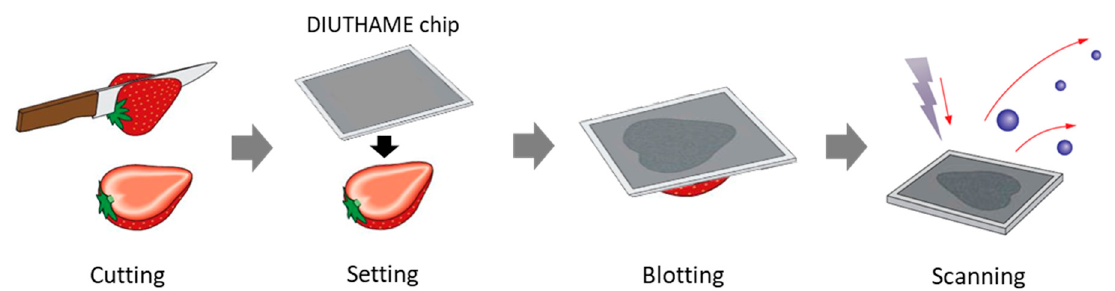
Figure 1. Workflow of the blotting method involving desorption ionization using through-hole alumina membrane (DIUTHAME) chip in mass spectrometry imaging.